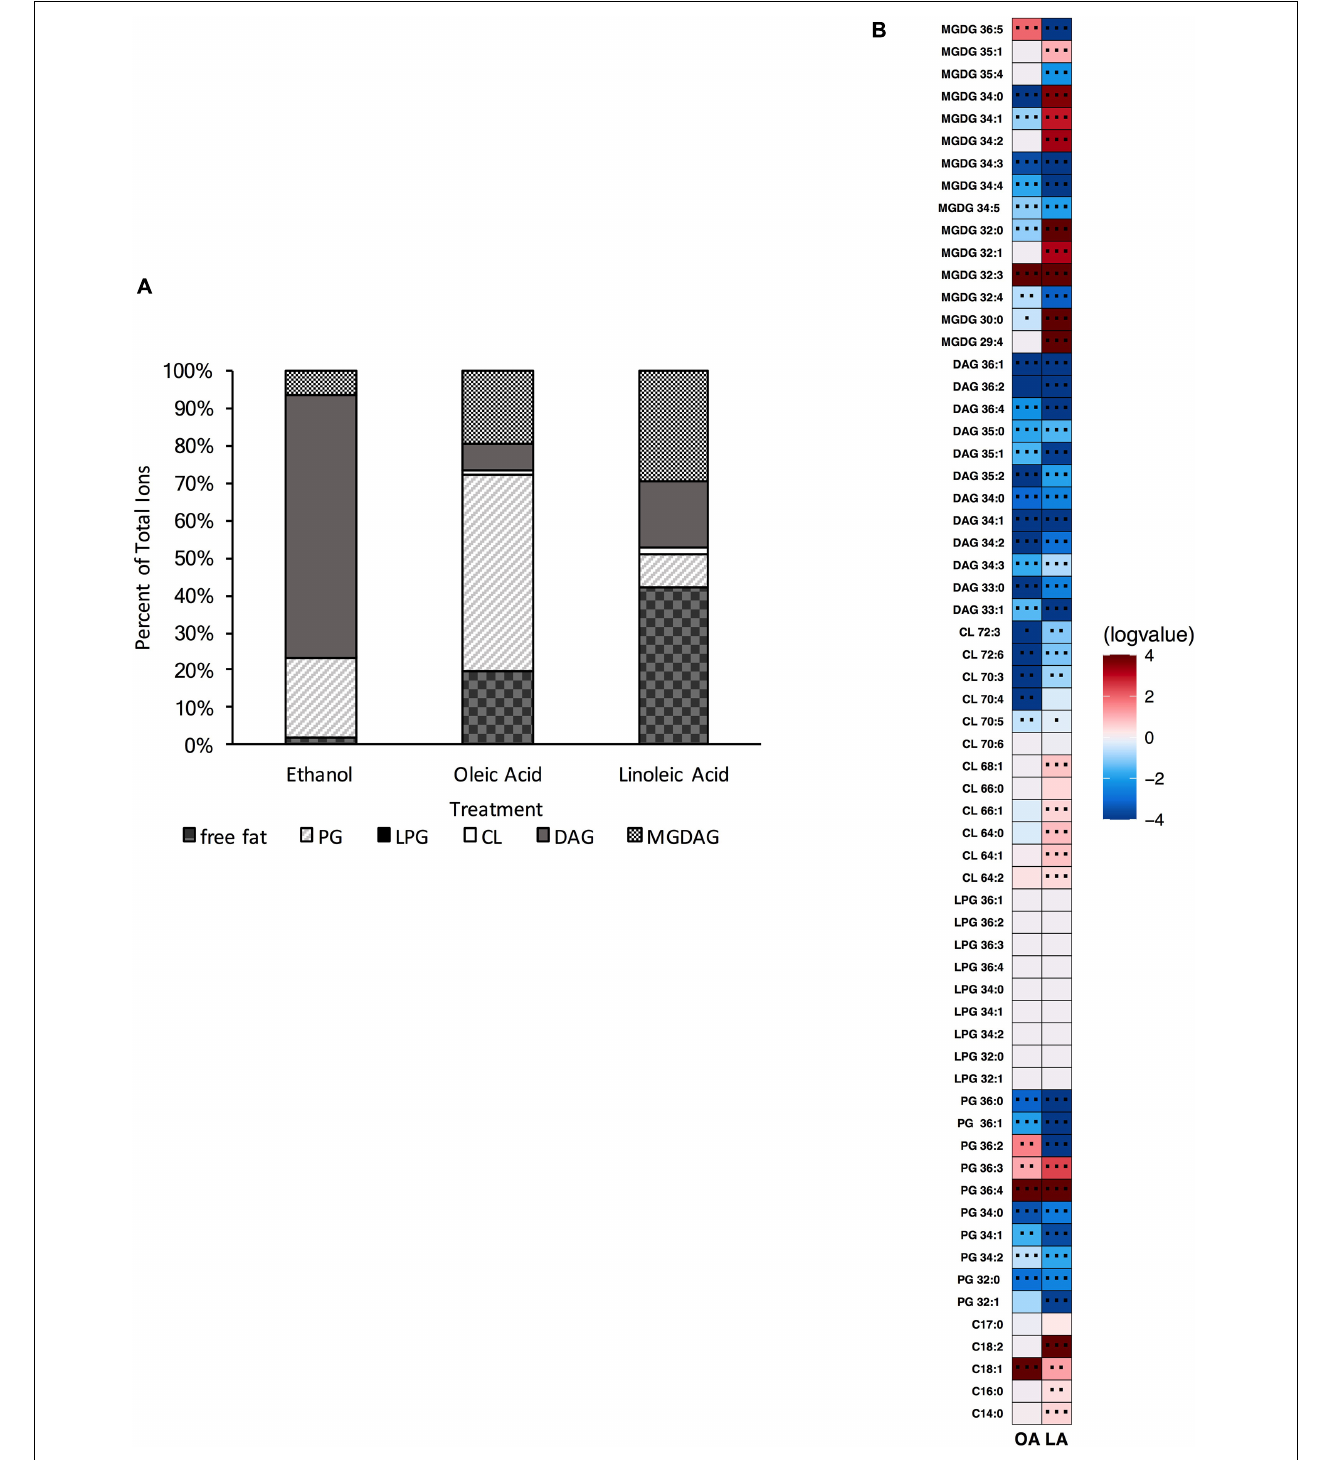
FIGURE 6 | A strain deleted for (cid:49) mprF2 can alter its lipid composition upon exposure to host fatty acids. (A) Percent totals of lipid species in solvent control: free fatty acids (2.1%), PG (20.9%), L-PG (0.0%), CL (0.5%), DAG (69.8%), and MGDG (6.7%), oleic acid: free fatty acids (19.9%), PG (52.5%), L-PG (0.0%), CL 1.0%), DAG (6.9%), and MGDG (19.7%), linoleic acid: free fatty acids (42.2%), PG (8.6%), L-PG (0.0%), CL (2.1%), DAG (17.6%), and MGDG (29.4%). Species were normalized to OD 600 nm . (B) Heat-map of fold changes upon fatty acid supplementation vs. solvent control; OA, oleic acid supplementation; LA, linoleic acid supplementation. Shown are the average fold changes of those detected lipid species above limit of detection for n = 5 samples. * P = 0.1–0.05; ** P = 0.05–0.01; *** P <